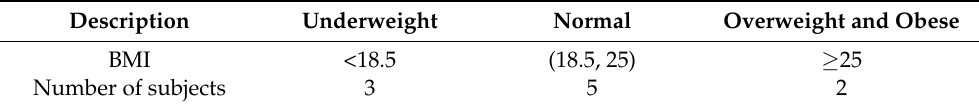
Table 2. BMI distribution of the